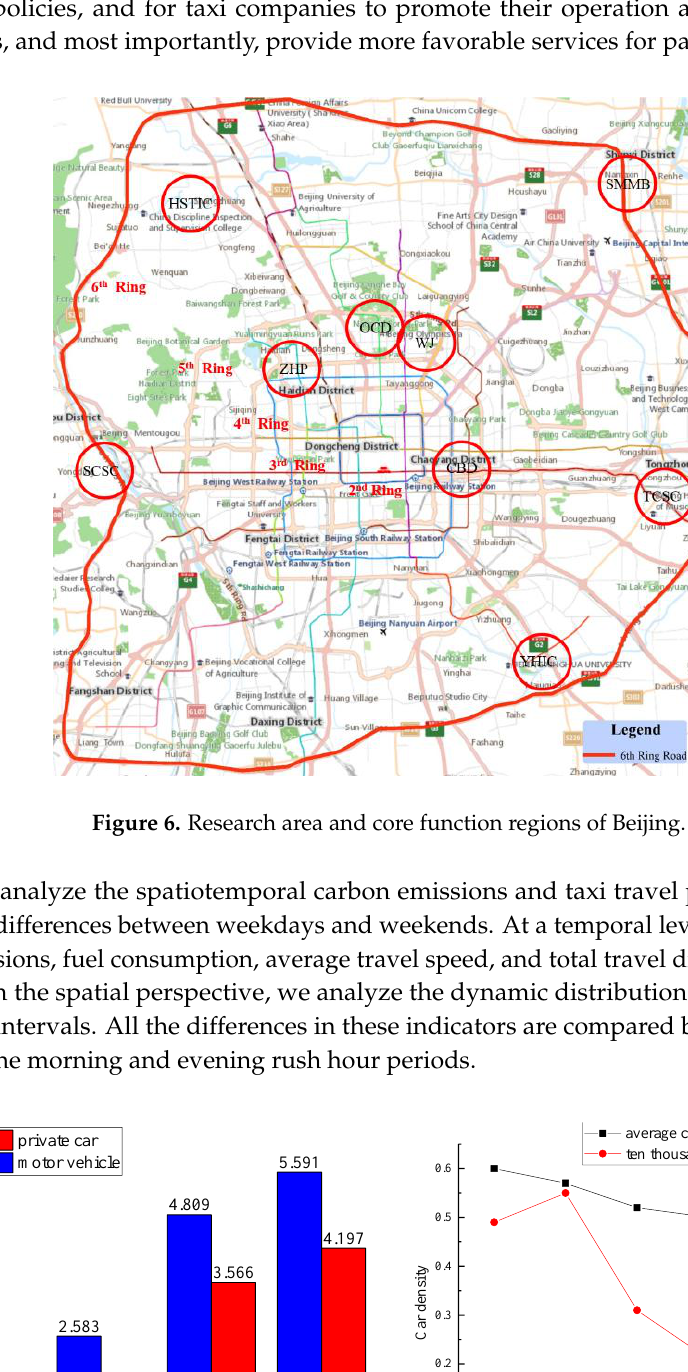
Figure 7. ( a ) Annual variation of cars and ( b ) spatial variation of cars with distance from ring roads in 2014.